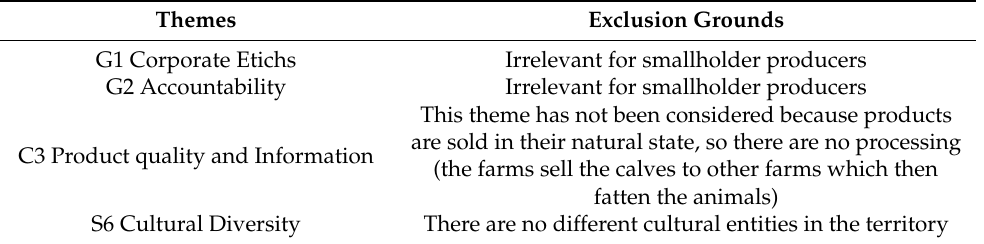
Table 1. List of sustainability themes and sub-themes excluded for being irrelevant within the assessment context.